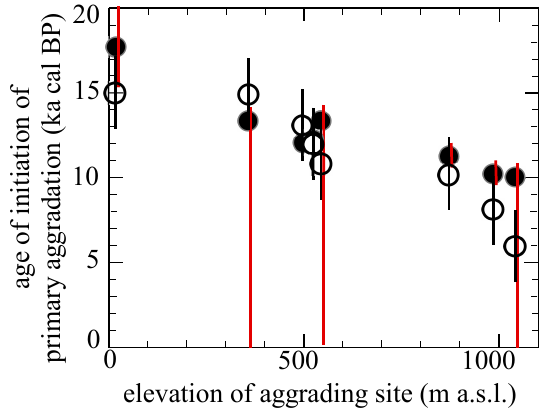
Figure 7. Plot of measured (closed circles) and predicted (open cir- cles) ages of the initiation of primary aggradation according to the PVCH. All data from Table 1 are plotted except for Chambless site, which was not included because of ambiguity in whether the site represents primary or secondary aggradation (see Sect. 4 for dis- cussion). Uncertainties of the measured ages are shown in red. Ages increase with decreasing elevation of the site of aggradation (which correlates with the lowest elevations of the source catchments). Un- certainty values are provided and explained in Table